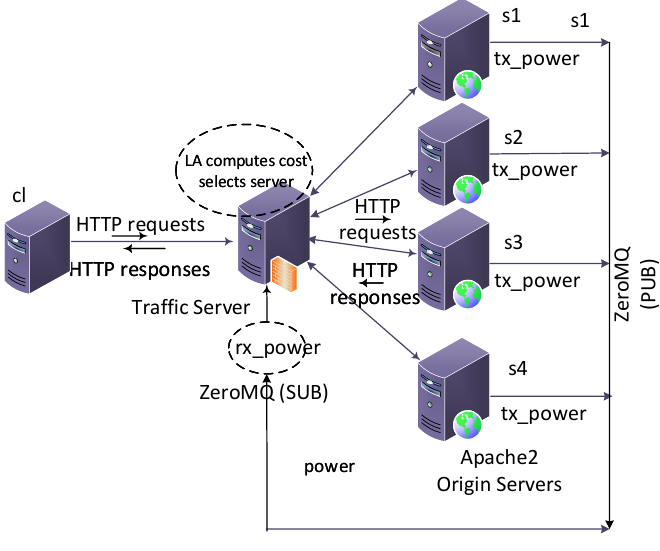
Figure 7. Experimental topology deployed in